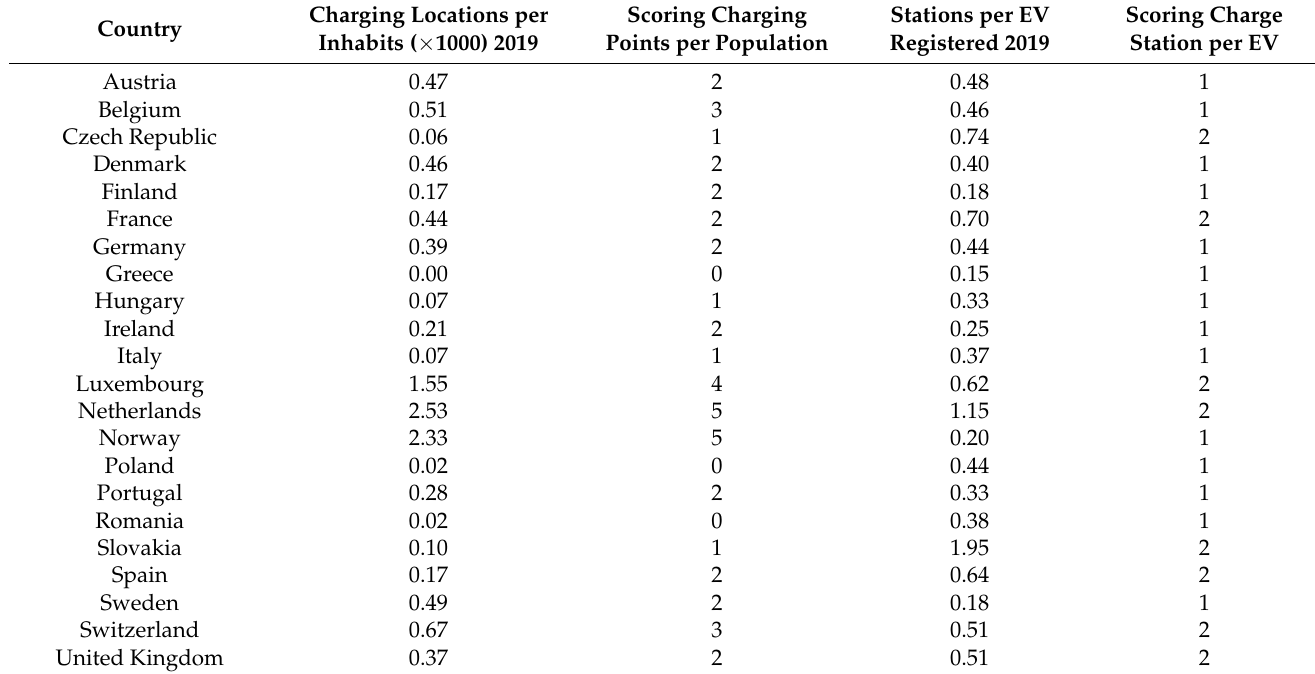
Table 2. EV market maturity in 2019 (Source: Leaseplan) [21].